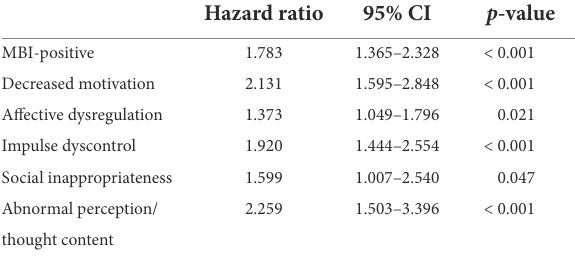
TABLE 4 Hazard ratios for progression to AD for MBI-positive and each MBI domain in multivariate Cox